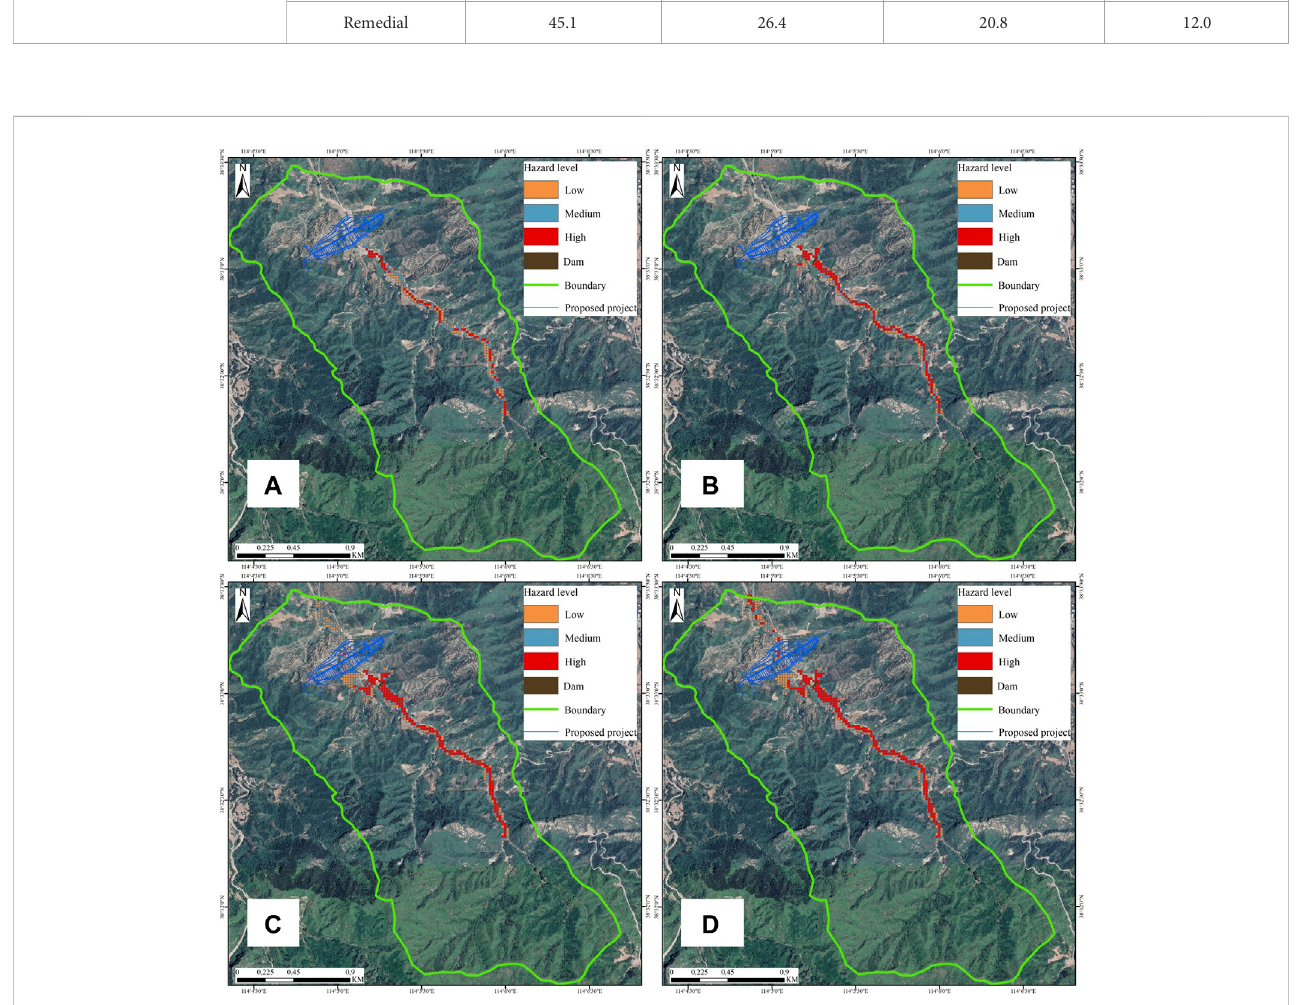
FIGURE 8 Hazard zonations with retaining dam at various rainfall frequencies. (A) (a)Hazard zonation with dam under 10-year rainfall, (B) (b)Hazard zonation with dam under 20-year rainfall, (C) (c)Hazard zonation with dam under 50-year rainfall, (D) (d)Hazard zonation with dam under 100-year